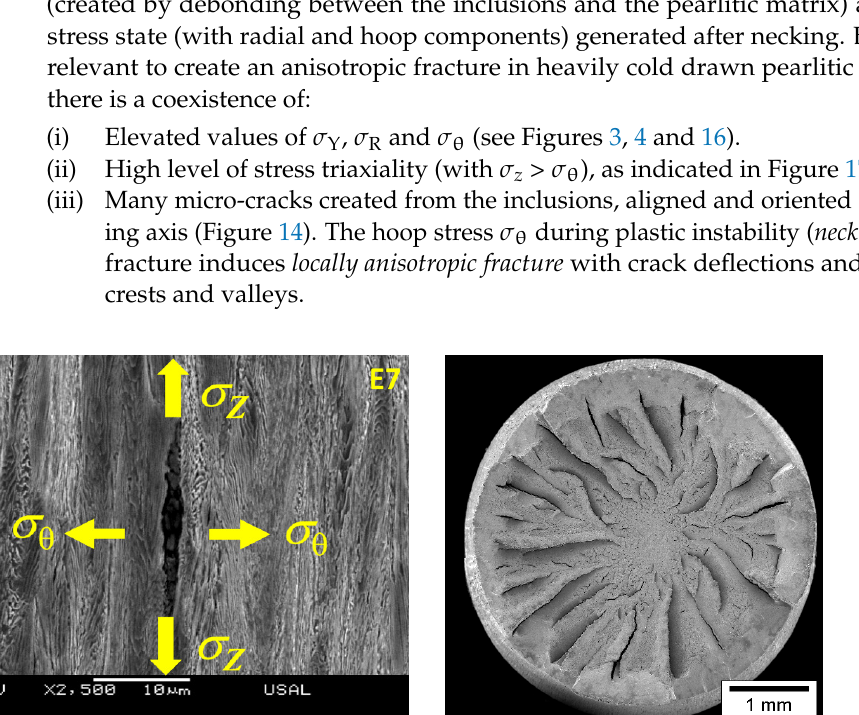
Figure 19. Isotropic fracture behavior in a hot rolled pearlitic steel (E0). 6. Conclusions The anisotropic fracture behavior of cold drawn pearlitic steel wires subjected to standard tension tests can be explained on the basis of the triaxial stress state generated during necking, together with the presence of many aligned and oriented micro-cracks generated during the cold drawing process. Such micro-cracks appear in the vicinity of second-phase particles ( inclusions ) in the course of manufacturing of prestressing steel wires by progressive cold drawing after debonding between the inclusion and the pearlitic matrix due to the differences with regard to plastic behavior between the matrix and the inclusion itself. Author Contributions: J.T. conceived and designed the research; F.-J.A. and B.G. performed the microscopy analysis, J.T., F.-J.A. and B.G. analyzed the data and wrote the paper. All authors have read and agreed to the published version of the manuscript. Funding: This research was funded by the following Spanish Institutions: Ministry for Science and Technology (MICYT; Grant MAT2002-01831), Ministry for Education and Science (MEC; Grant BIA2005-08965), Ministry for Science and Innovation (MICINN; Grant BIA2008-06810), Ministry for Economy and Competitiveness (MINECO; Grant BIA2011-27870) and Junta de Castilla y León (JCyL; Grants SA067A05, SA111A07, SA039A08 and SA132G18). Institutional Review Board Statement: Not applicable. Informed Consent Statement: Not applicable. Data Availability Statement: Not applicable. Conflicts of Interest: The authors declare no conflict of interest. The funders had no role in the design of the study; in the collection, analyses, or interpretation of data; in the writing of the man- uscript, and in the decision to publish the results.